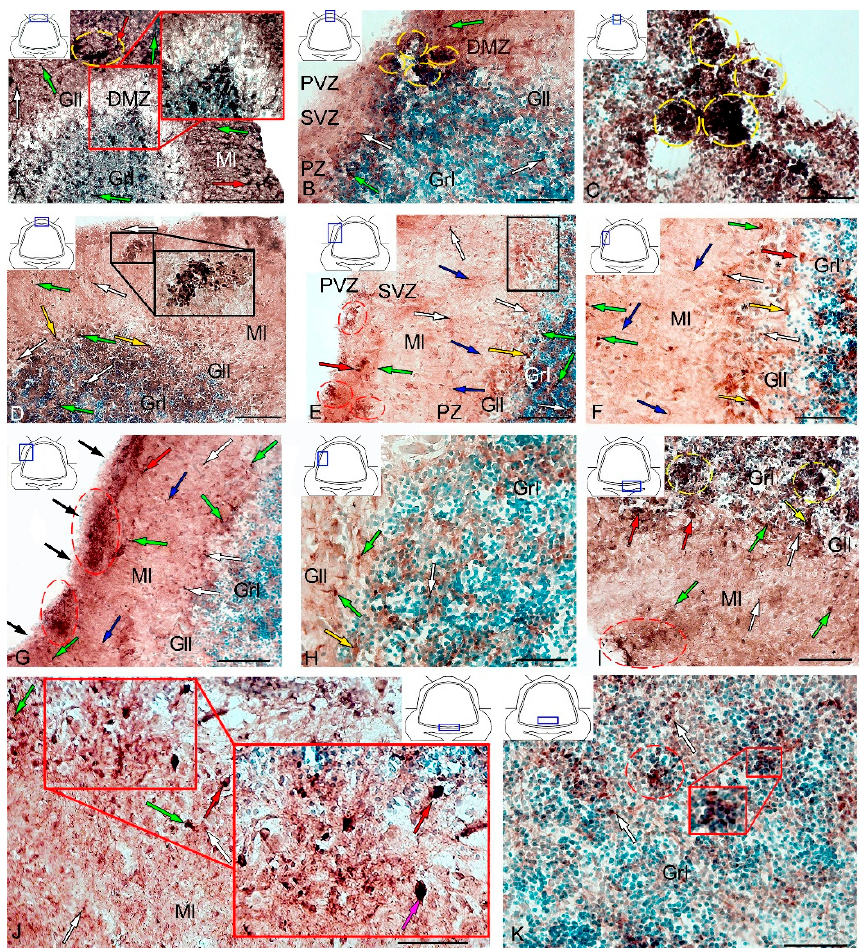
Figure 14. Distribution of CBS in the cerebellum of juvenile masu salmon, Oncorhynchus masou , on day 2 post-injury. ( A ) General view of the dorsal zone (DZ) in the rostral part of the cerebellum: dorsal matrix zone (DMZ) (red inset); CBS+ type 1 cells (white arrows); CBS+ type 2 cells (green arrows) and CBS+ 3 cells type (red arrows); aggregation of CBS+ cells (yellow dotted oval); ganglionic layer (Gll); granular layer (Grl); molecular layer (Ml). ( B ) General view of the DZ in the caudal part of the cerebellum: aggregations of CBS+ cells in the DMZ (yellow dashed oval), periventricular zone (PVZ), subventricular zone (SVZ), parenchymal zone (PZ), and other designations see in Figure 14A. ( C ) Area of injury, see designations in Figure 14B. ( D ) DZ containing reactive neurogenic niches with CBS+ cells in their composition (black inset): an aggregation of CBS+ cells in the PVZ of the molecular layer (red dotted oval. ( E ) General view of the LZ in the rostral part of the cerebellum: eurydendroid cells (yellow arrows); migrating CBS − cells (blue arrows); aggregations of CBS+ cells in the PVZ of the molecular layer (red dashed oval); the fragment shown in Figure 14F is outlined by black rectangle. ( F ) The enlarged fragment of the LZ in the rostral part of the cerebellum: eurydendroid cells (yellow arrows); migrating CBS − cells (blue arrows). ( G ) General view of the LZ in the caudal part of the cerebellum: migrating CBS − cells (blue arrows); CBS − cells in the surface layer (black arrows); aggregations of CBS+ cells in the PVZ of the molecular layer (red dashed oval). ( H ) Granular layer of the LZ part of the cerebellum: see designations in Figure 14A. ( I ) BZ: aggregation of CBS+ cells in the PVZ of the molecular layer (red dashed oval); aggregation of CBS+ cells in the granular layer (yellow dotted oval). ( J ) Granular layer of the BZ: aggregation of CBS+ cells (red dotted oval); aggregation of CBS+ cells (red inset); Purkinje cells (pink arrows). ( K ) Granular layer of the BZ (red inset). IHC CBS labeling. The blue rectangle in the pictogram indicates the corresponding area in the micrograph. Scale bars: ( A ) 200 μ m; ( B – G , I – K ) 100 μ m; ( H ) 50 μ m. In the LZ, the number of moderately/intensely labeled CBS+ cells of types 1 and 2 similarly increased (Figure 14E, Table S4). More intensely labeled type 1 cells formed local clusters in the PVZ